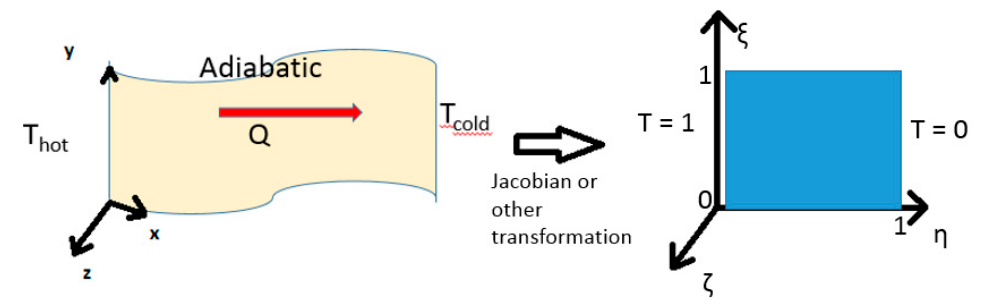
Figure 5. Mapping of general design space to machine learning data set space.